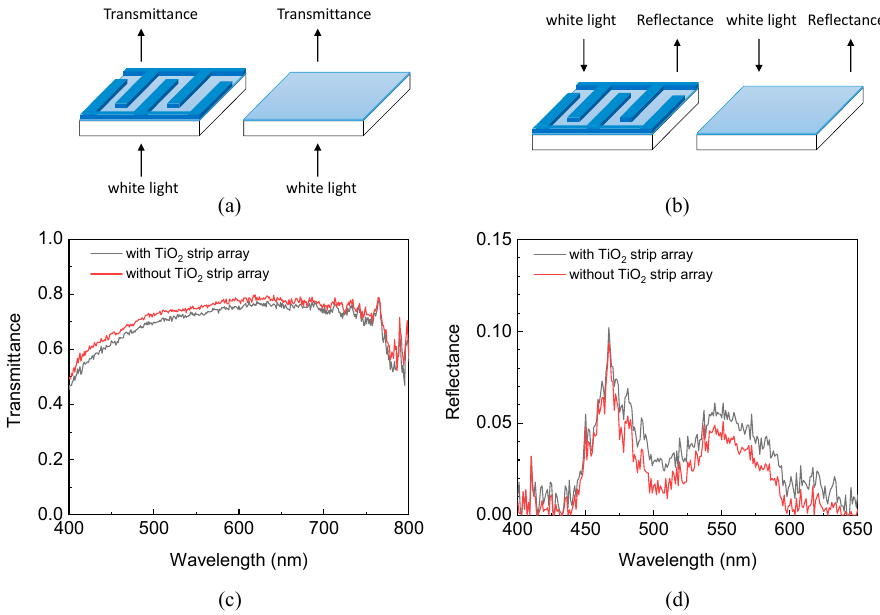
Figure 4. Setups of ( a ) transmission and ( b ) reflection spectra of FTO glass substrates with and without the TiO 2 strip array. ( c ) Transmission and ( d ) reflection spectra of FTO glass substrates with and without the TiO 2 strip array.